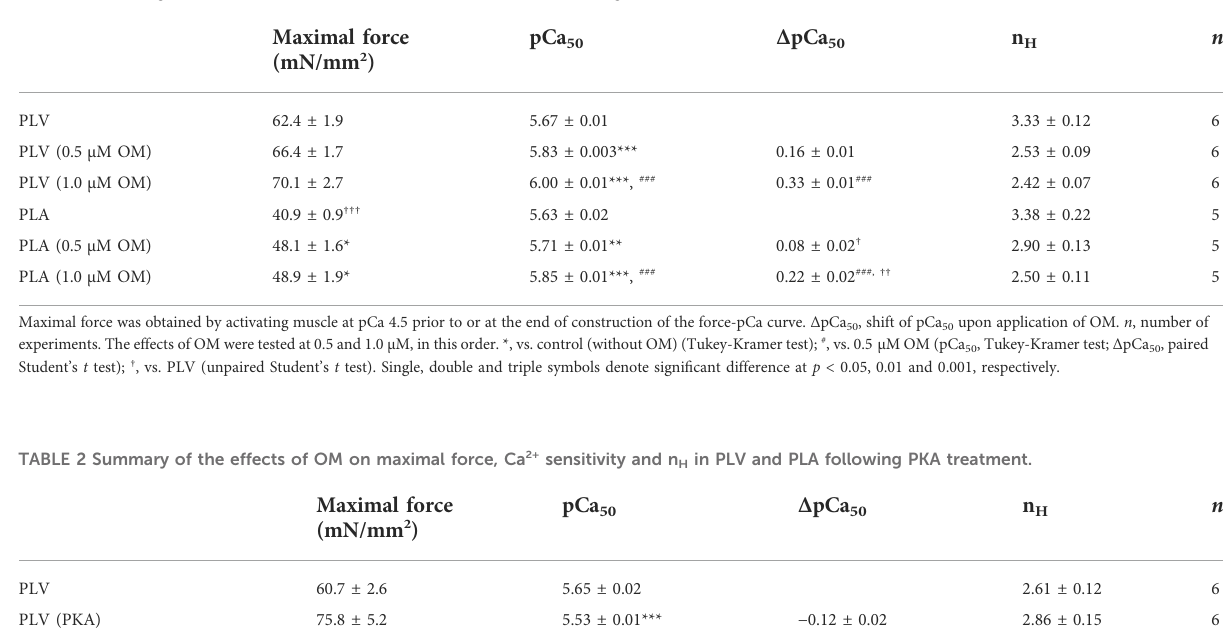
TABLE 1 Summary of the effects of OM on maximal force, Ca 2+ sensitivity and n H in PLV and PLA.